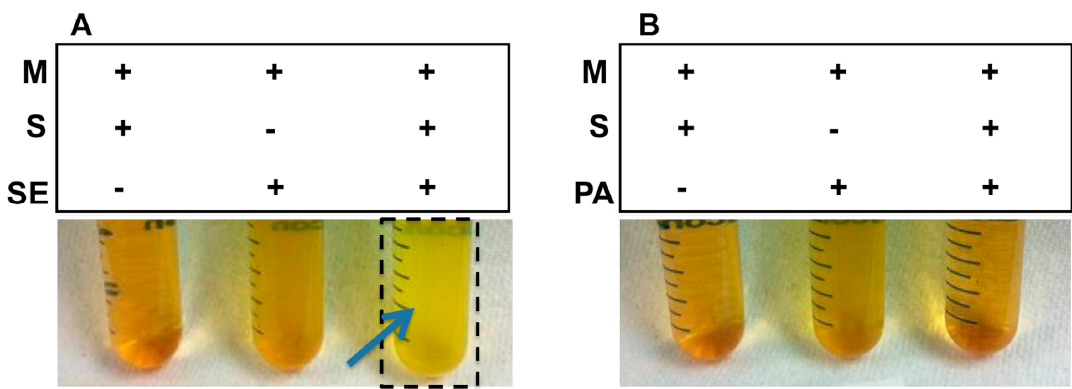
Figure 1. Sucrose as a selective carbon source for Staphylococcus epidermidis ( S. epidermidis ) fermentation. ( A ) S. epidermidis (SE) or ( B ) Propionibacterium acnes ( P. acnes , PA) (10 5 CFU/mL) was incubated in rich media (M) with or without 20 g/L sucrose (S) for six days. Rich media plus sucrose without bacteria was included as a control. S. epidermidis , but not P. acnes , fermented sucrose. A color change to yellow in the media (marked in a black frame and blue arrow) indicates that sucrose fermentation of S. epidermidis has occurred. Representative data from three independent experiments are shown.